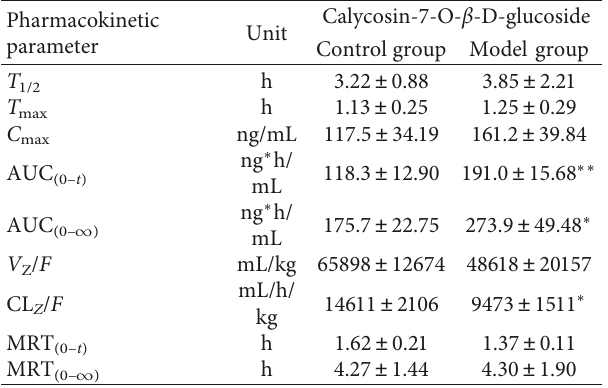
Table 8: The pharmacokinetic parameters of calycosin-7-O- β -D- glucoside after HQD administration ( x ± SD, n � 8).